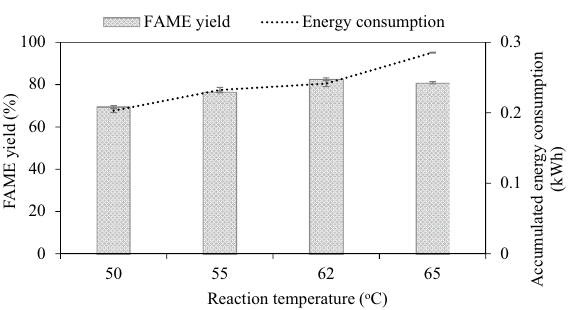
Figure 5. Effect of reaction temperature on steady-state FAME yield (refined palm oil, 2000 mL, 50 mL/min, 1 wt% NaOH).